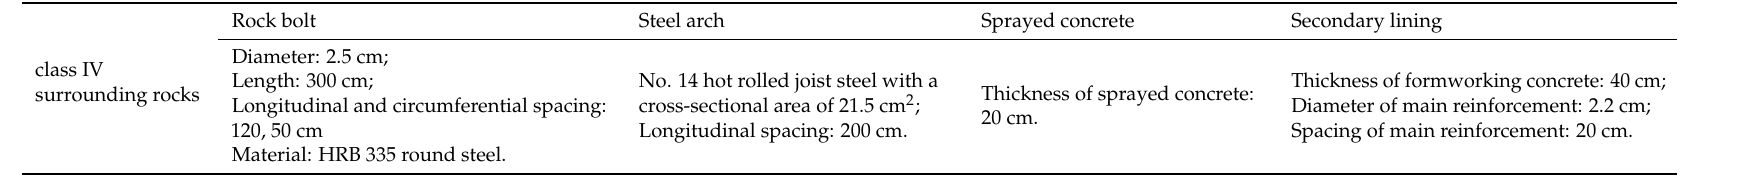
Table 2. Detailed parameters of primary and secondary supports in class IV surrounding rocks.